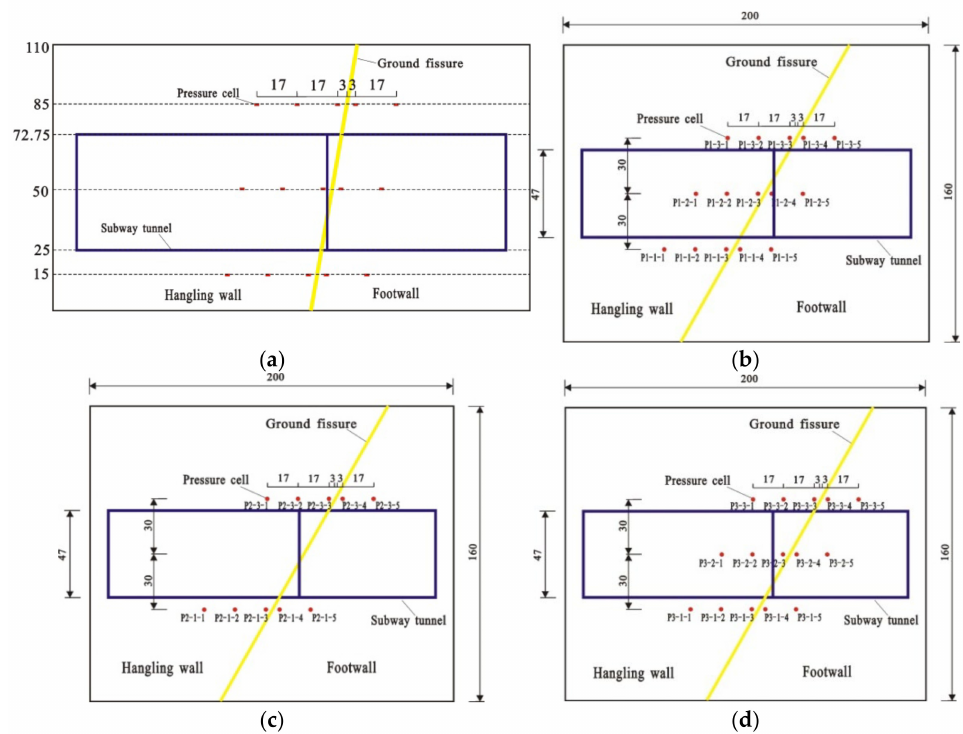
Figure 6. Layout of pressure cells in the soil (unit: cm): ( a ) elevation view of pressure cells layout; ( b ) top view of pressure cells layout at the height of 15 cm; ( c ) top view of pressure cells layout at the height of 50 cm; ( d ) top view of pressure cells layout at the height of 85 cm.